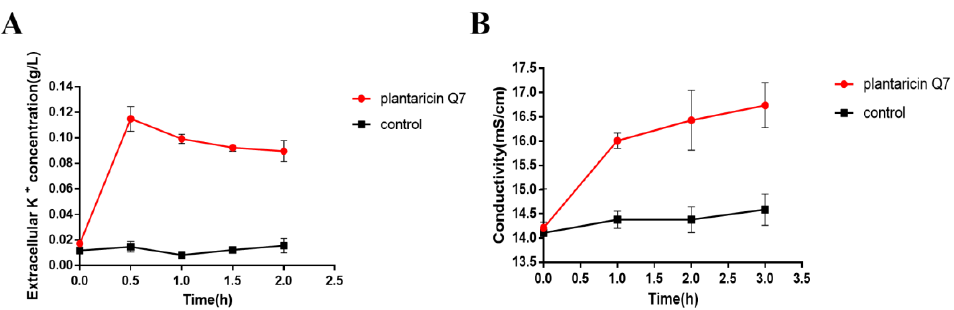
Figure 4. Effects of plantaricin Q7 on K + concentration and electrical conductivity of L. monocyto- genes . ( A ) K + concentration. ( B ) Electrical conductivity. The data were shown as mean ± SD ( n = 3).